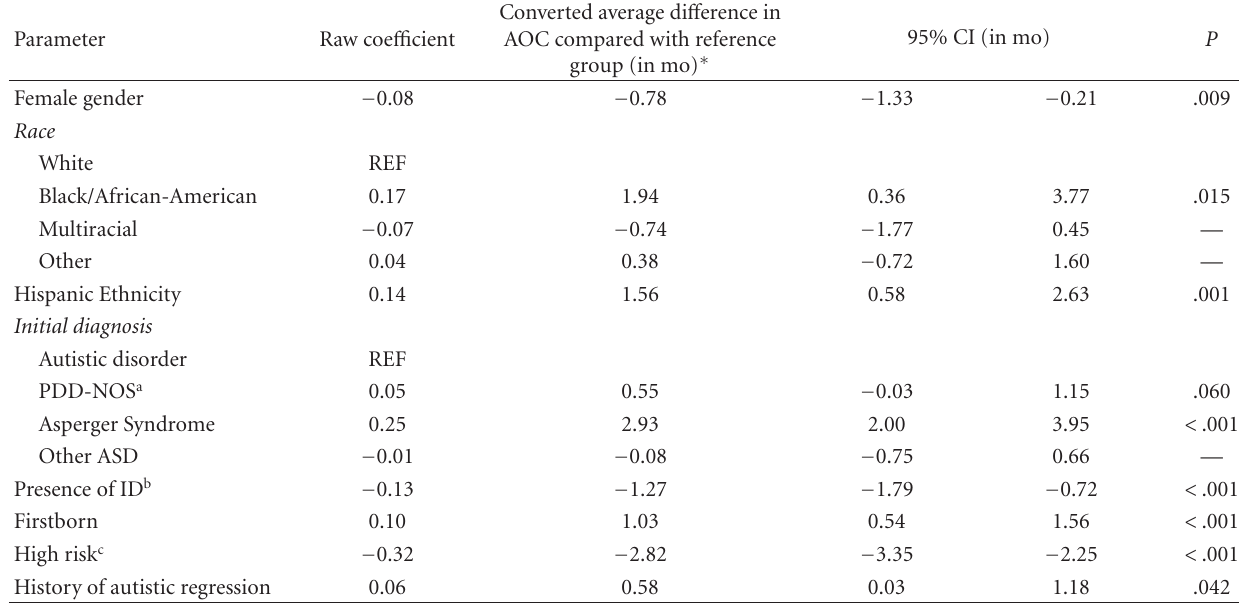
Table 2: Multivariate linear regression of factors a ff ecting log-transformed age at first parent concern (AOC) among 6214 individuals with